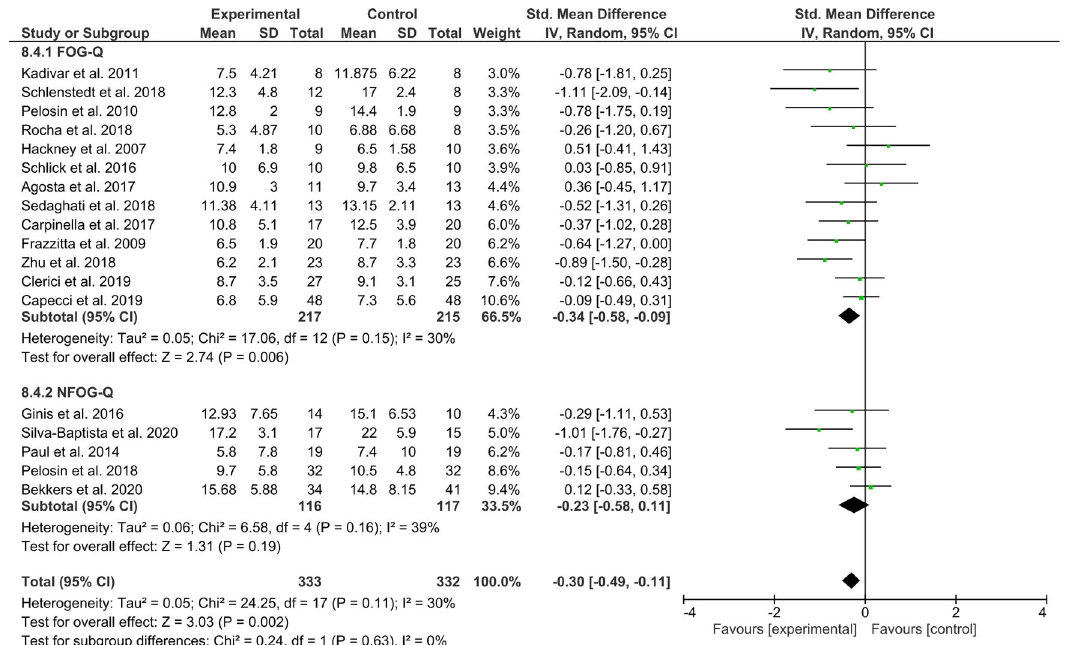
Fig. 5 Secondary analysis comparing the effect of all types of training/exercise against active control groups. The studies are arranged per weight of the study as based on sample A total of 18 studies compared the intervention of interest to an active control of similar exposure. Synthesizing their combined effects across N intervention = 333 and N control = 332 revealed a favorable moderate effect for the intervention groups ( Z = 3.03, p = 0.002, ES = − 0.30 [ − 0.49, − 0.11]) with acceptable statistical heterogeneity ( χ 2 (17) = 24.25, p = 0.11, I 2 = 30%) and no signi fi cant outliers. The forest plot is presented in Fig. 5.